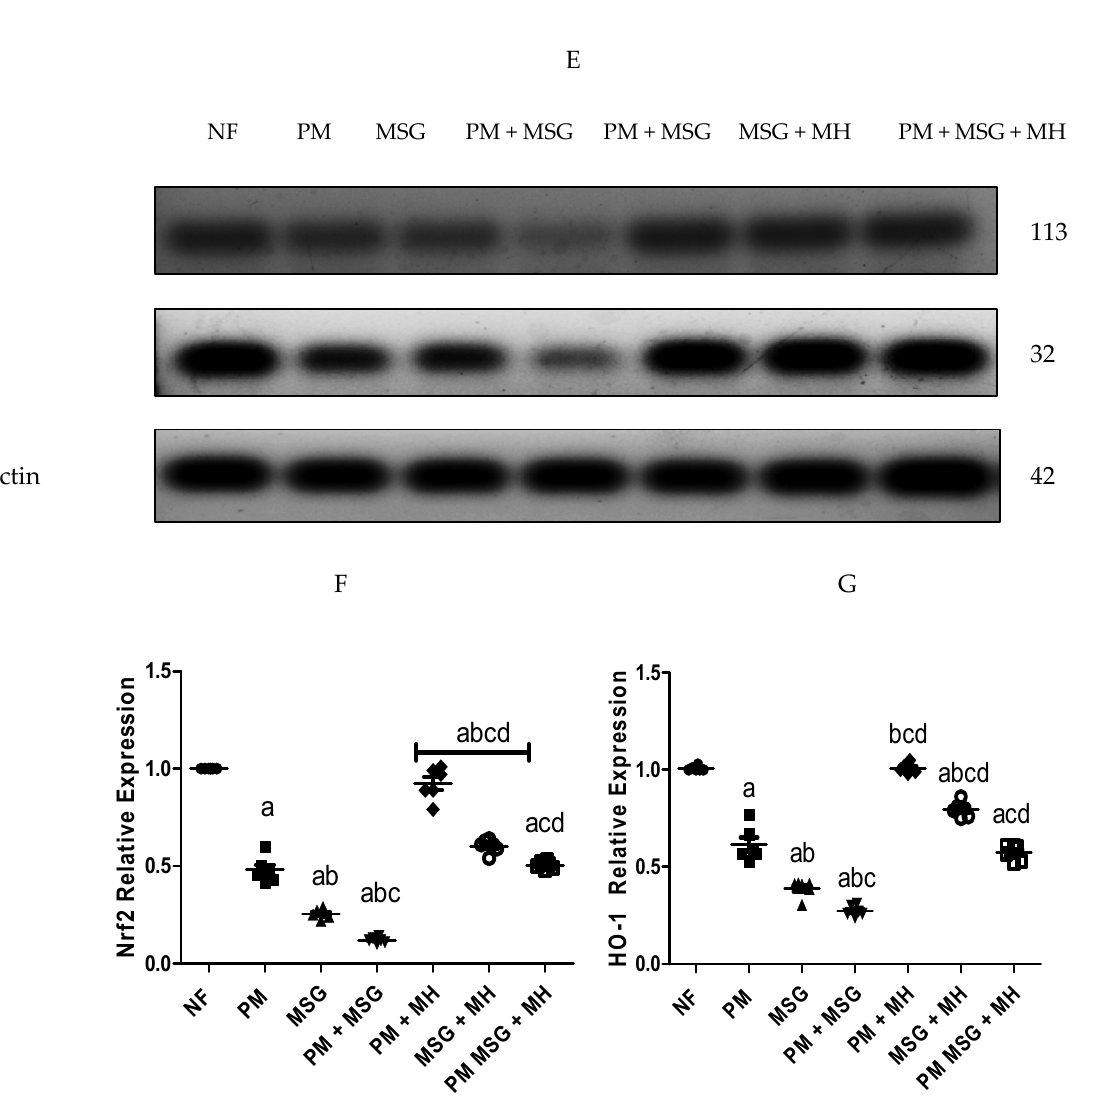
Figure 7. MH modify brain oxidative stress biomarkers of PM and/or MSG—fed rat pups. Effect of MH (60 mg/kg) (MH) on brain oxidative stress biomarkers of PM or/and MSG rats on the level of: TAC ( A ); SOD ( B ); reduced glutathione ( C ); and MDA ( D ) on the protein level using ELISA. Immunoblotting membranes represented nuclear fractions of Nf2 expression and HO-1 and β -actin was used a loading protein control ( E ). Relative protein expression of Nrf2 ( F ) and HO-1 ( G ). Data presented as mean ± SEM ( n = 6). a–d depict significant difference regarding NF, PM, MSG, PM + MSG groups, respectively at p < 0.05. Statistical analysis was performed using one-way ANOVA, followed by Tukey’s post hoc test. [The data of the effect of MH on the control NF is not shown as it is not significant].